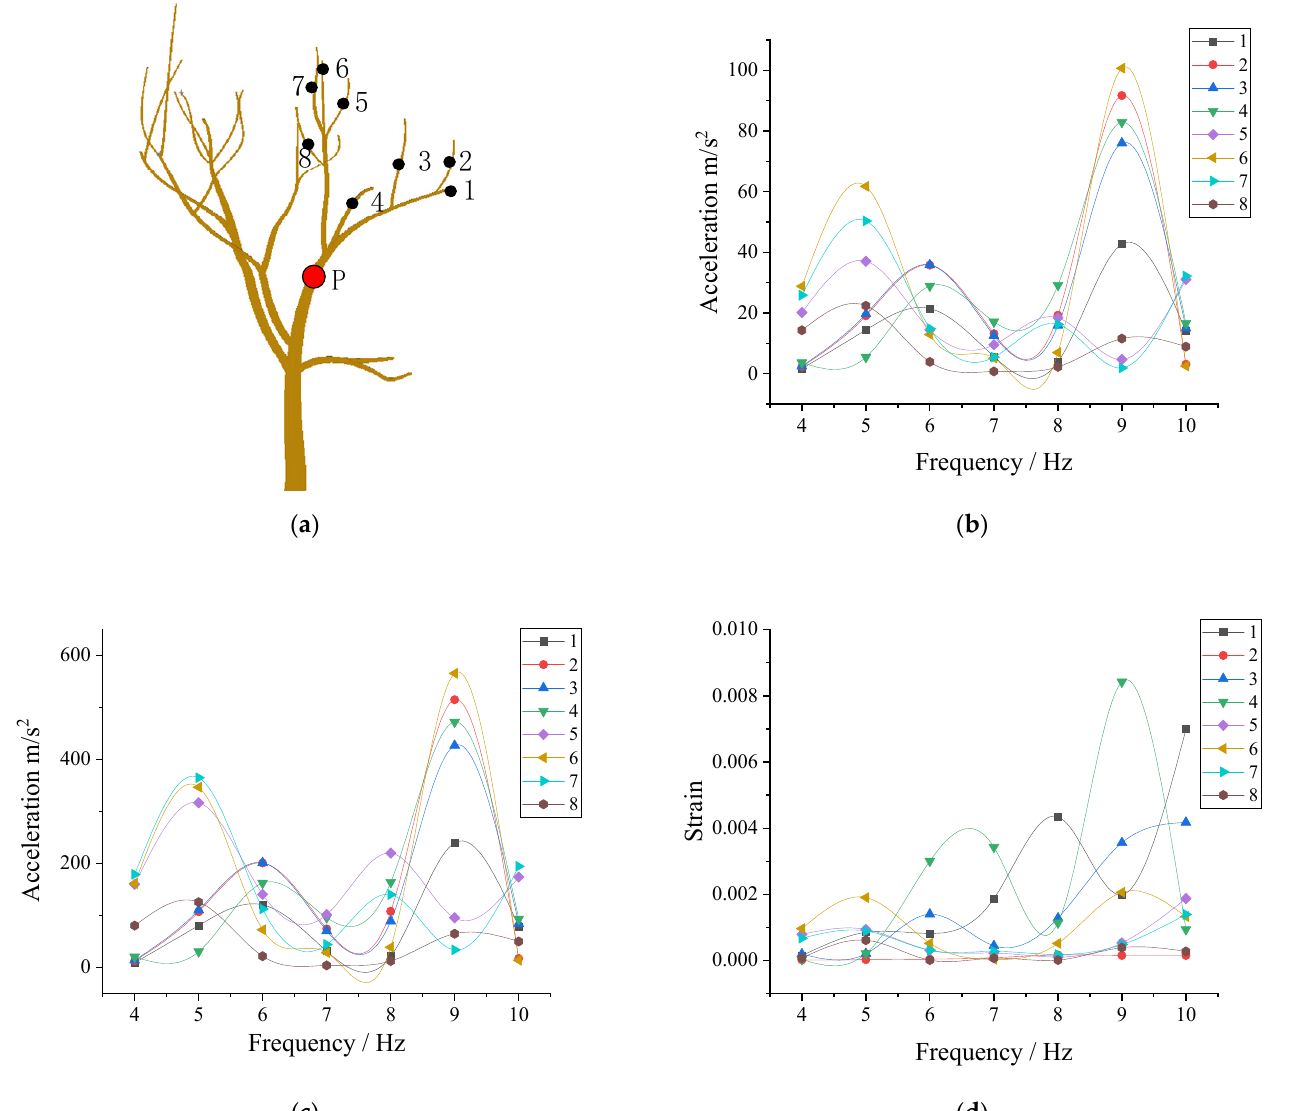
Figure 9. Harmonic response analysis of Camellia oleifera canopy under stress. ( a ) 8 representative points when the vibration position is point P; ( b ) Acceleration response of 8 representative points when 10 mm displacement load is applied to the canopy; ( c ) Acceleration response of 8 representative points when 56 mm displacement load is applied to the canopy; ( d ) Strain response of 8 representative points under 56 mm displacement load on canopy.